Question: Sum up the contents of this chart in one sentence.
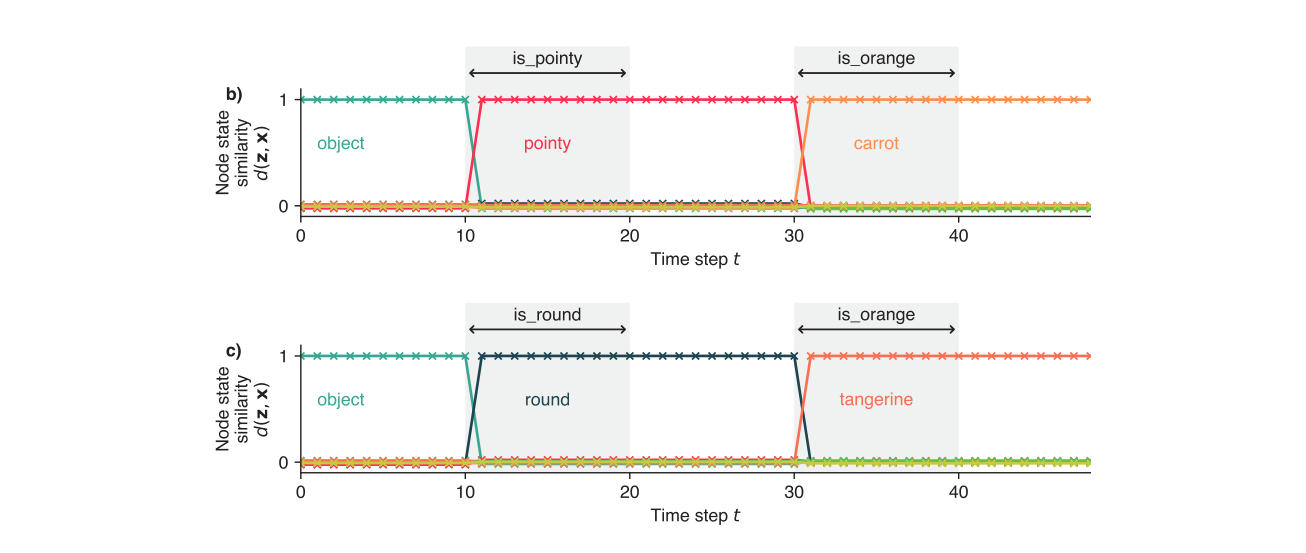
Answer: Embedding an FSM that does not require edge states, since it does not have consecutive edges with the same stimulus. a) The FSM to be embedded, representing a simple decision tree. b) & c) An attractor network constructed to store this FSM, without any edge states, as a sequence of stimuli is input. The network performs the correct walks between attractor states as desired. To note is that the second stimulus (“is orange”) and its transition are state-dependent, as the target state (“carrot” or “tangerine”) is dependent upon the stimulus given 20 time steps before (“is round” or “is pointy”). This illustrates that the edge states are not strictly necessary to implement state-dependent transitions between attractor states.